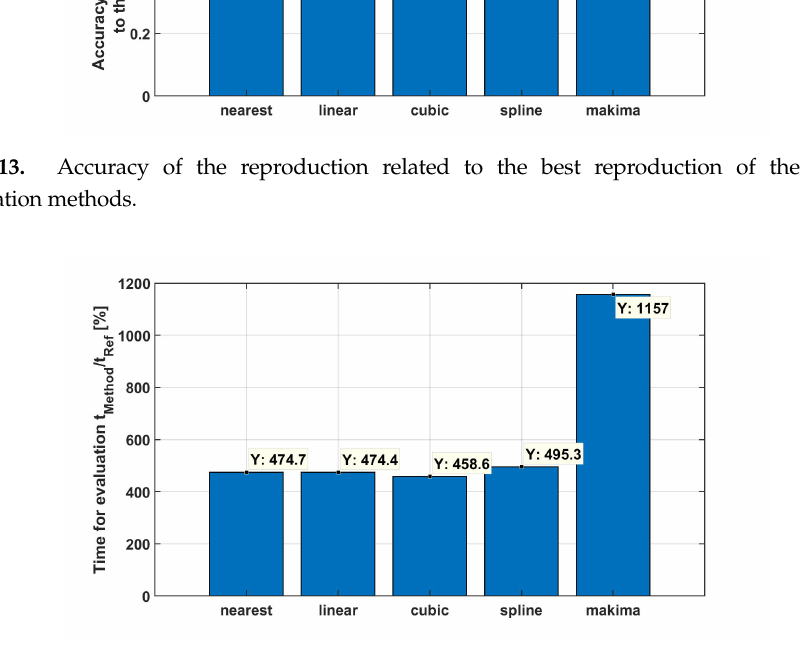
Figure 14. Time for the evaluation of the different refinement methods related to the “default” evaluation